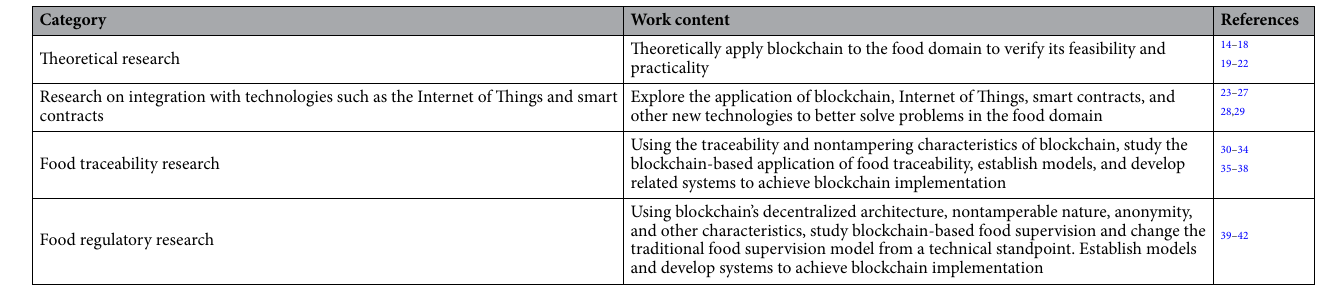
Table 1. Application of blockchain technology in the field of food